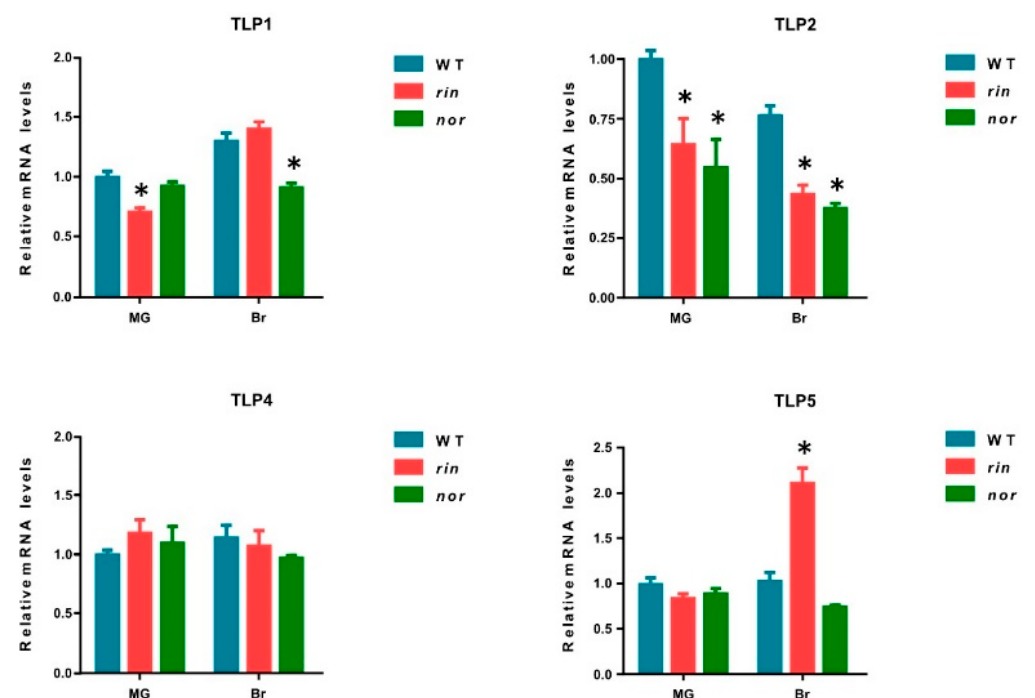
Figure 6. Expression of TLP1 , TLP2 , TLP4 , and TLP5 in WT, rin , and nor (MG: mature green fruit; Br: Breaker stage fruit; WT: Wild type; rin: ripening inhibitor mutant; nor: non-ripening mutant . The values represent the means of three biological replicates. *, p < 0.05 (Student’s t -test).).